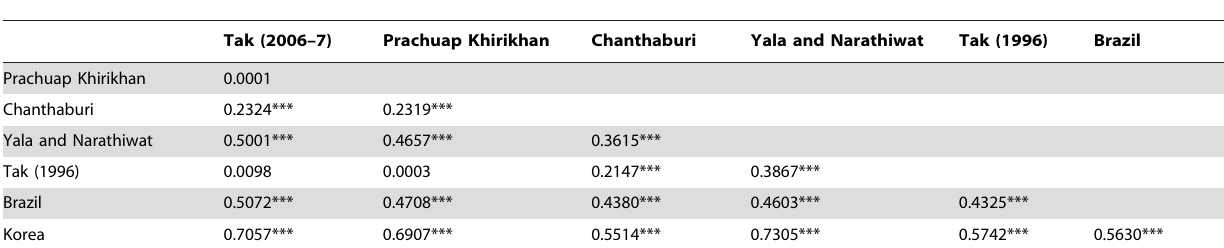
Table 3. Genetic differentiation ( F ST indices) of P. vivax populations based on the PvTRAP locus.